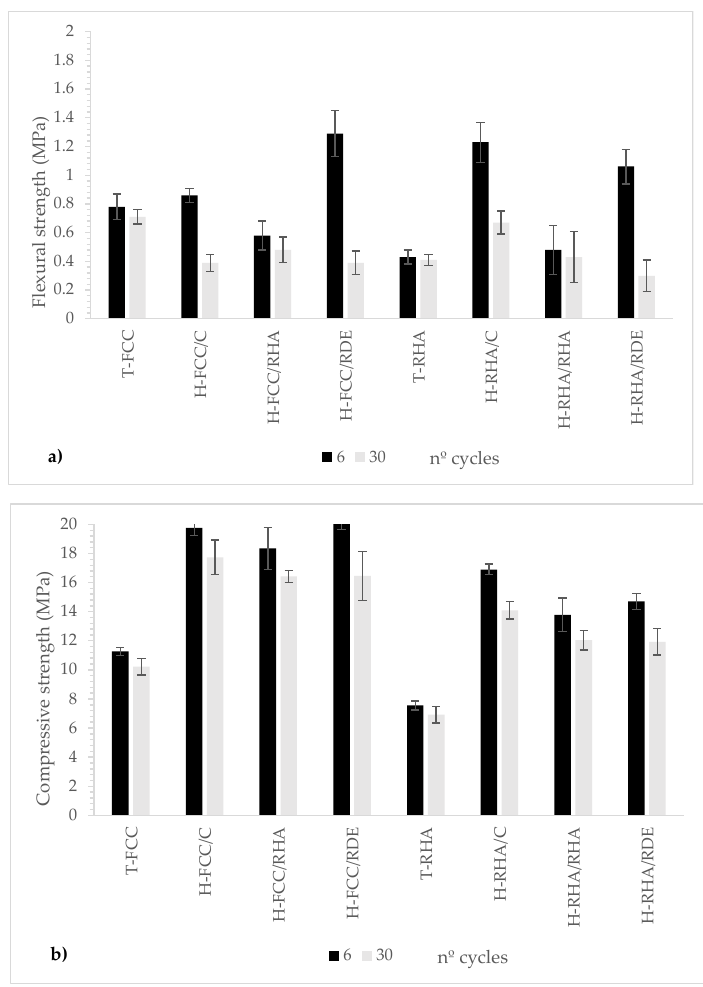
Figure 7. Mechanical properties after freeze–thaw cycles: ( a ) flexural strength; ( b ) compressive strength.